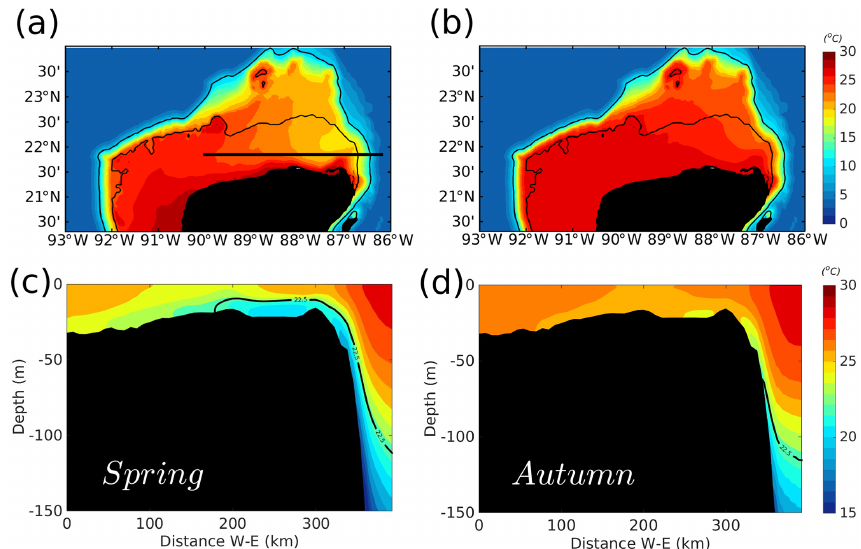
Figure 3. Seasonal climatology of bottom temperature ( ◦ C) for (a) spring and (b) autumn, for the period between 2002 and 2010. The corresponding vertical sections, indicated by the zonal black line in (a) , are shown for (c) spring and (d) autumn. The contours in (a) and (b) denote the 50 and 250m isobaths. The black contour in (c) and (d) shows the upwelling isotherm of 22.5 ◦ C.